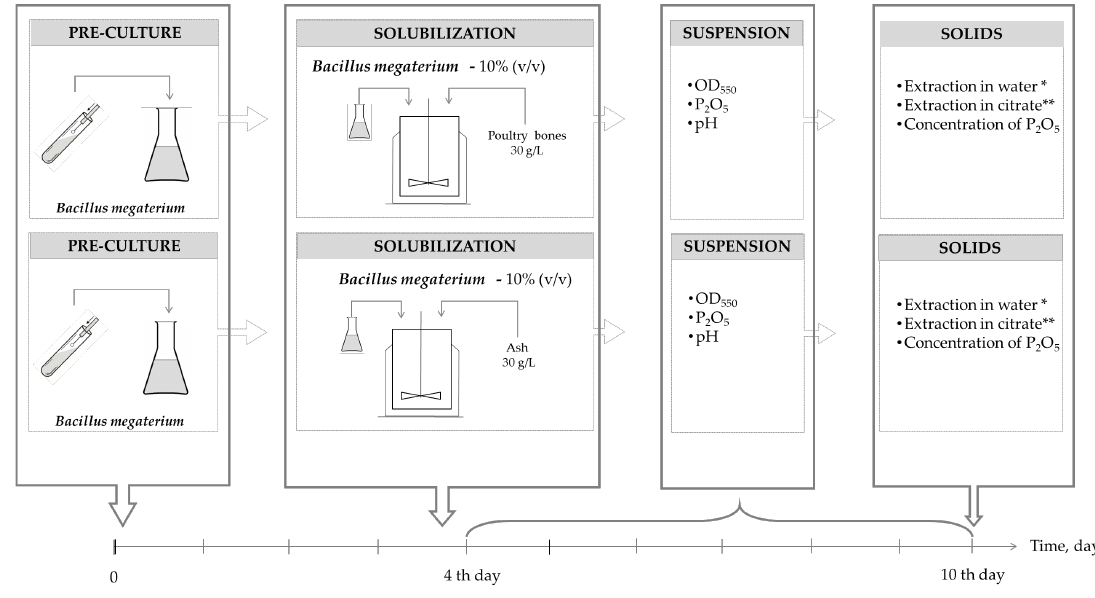
Figure 1: Scheme of the conducted